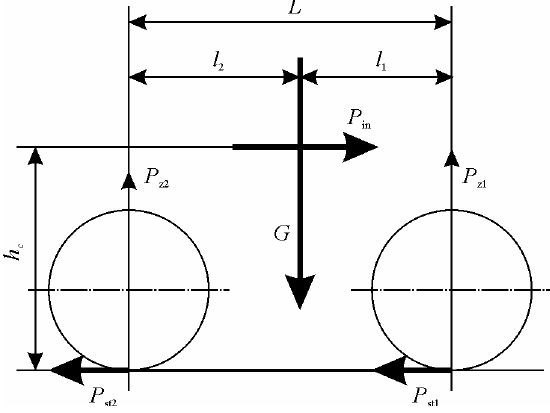
Fig 3. The forces that impact a vehicle on its